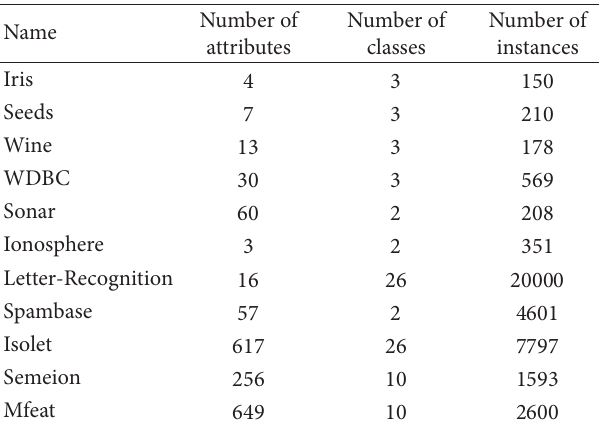
Table 1: Data sets used in the experiments.